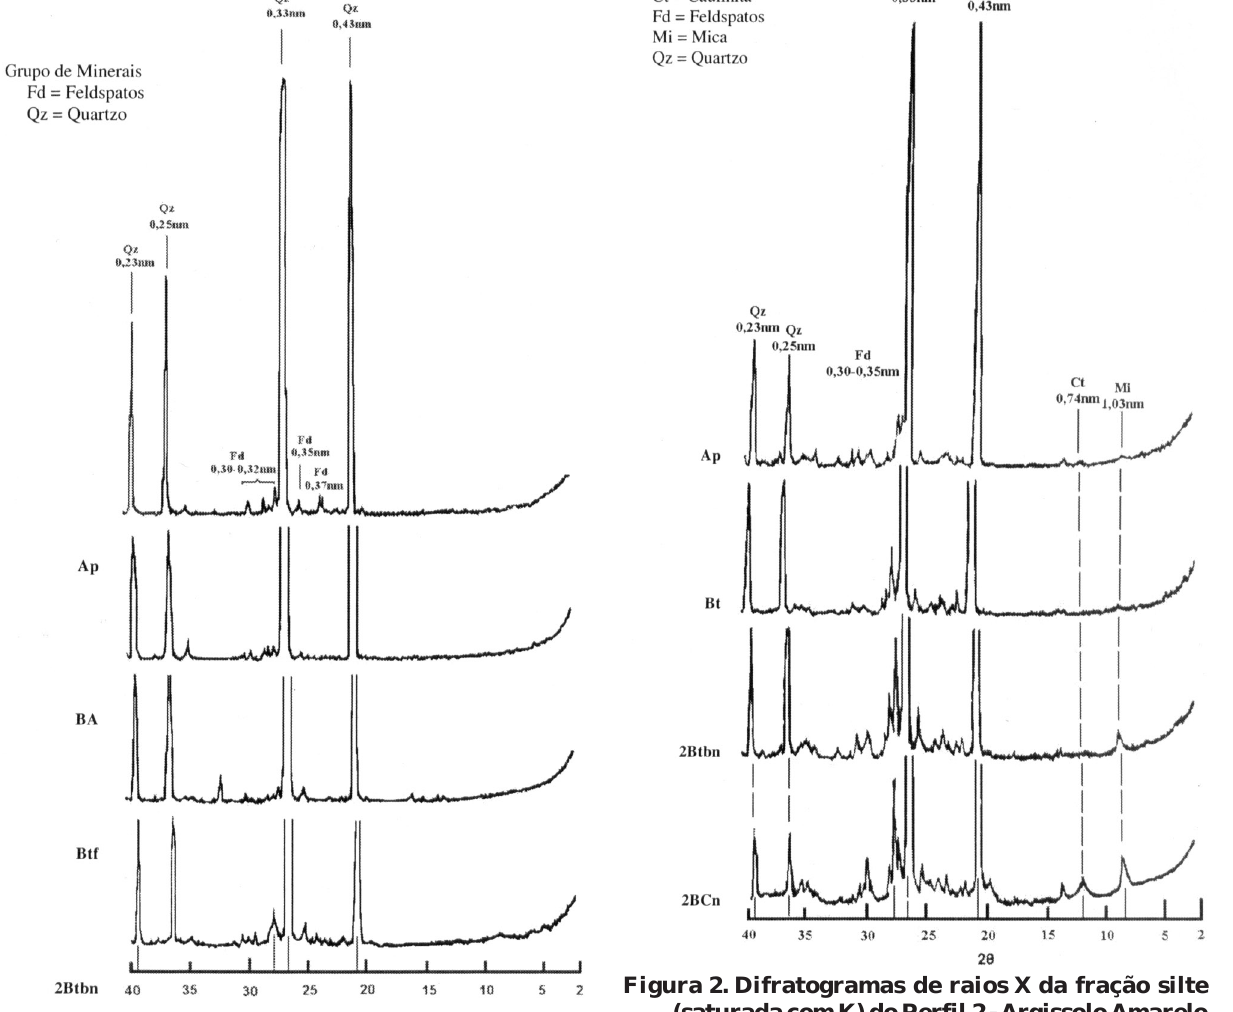
Figura 1. Difratogramas de raios X da fração silte (saturada com K) do Perfil 1 - Plintossolo Argilúvico eutrófico planossólico sódico.